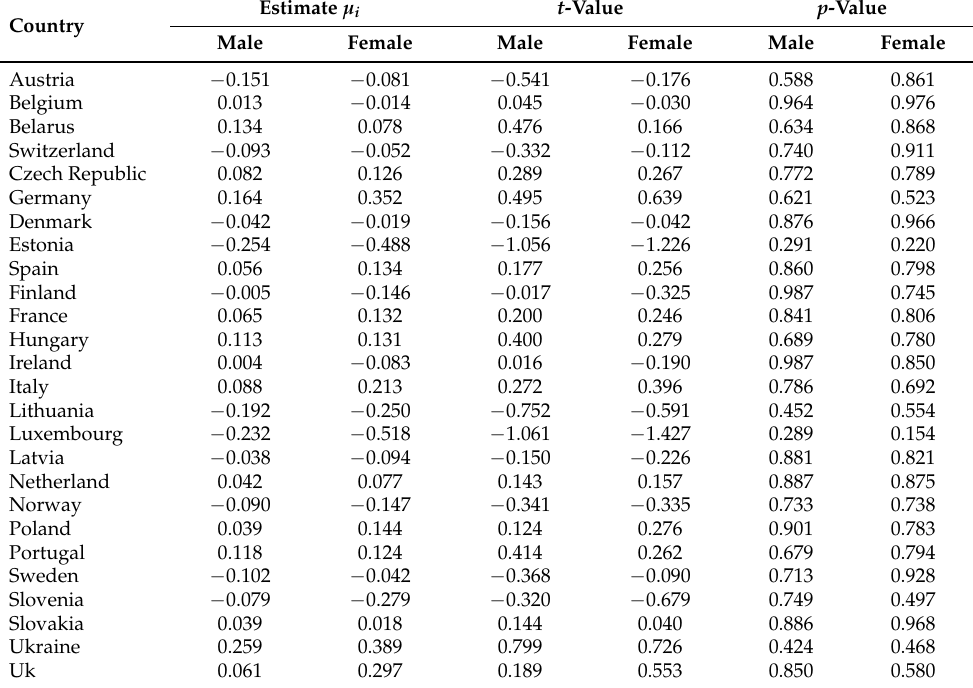
Table 5. Estimation of spatial effects of SLMSFE model with MATLAB.